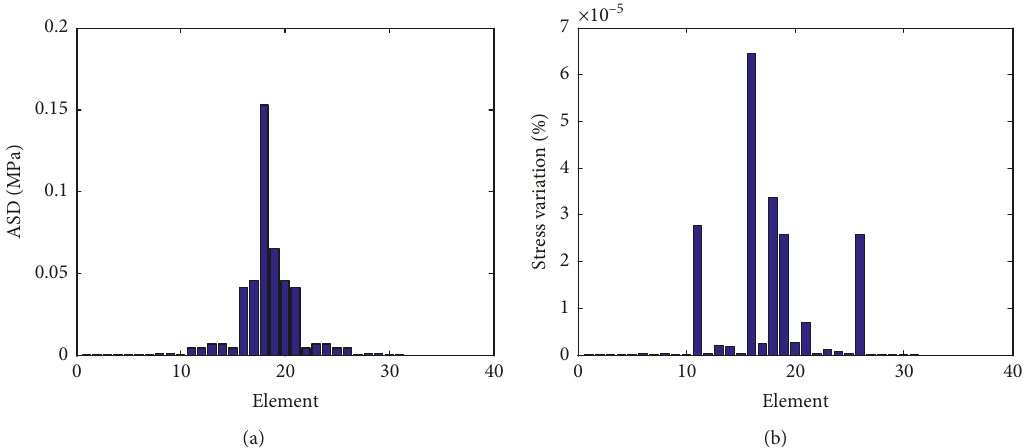
Figure 9: A single damage at element 18 using noise-free displacements and global-based approach of (a) ASD and (b) stress variation